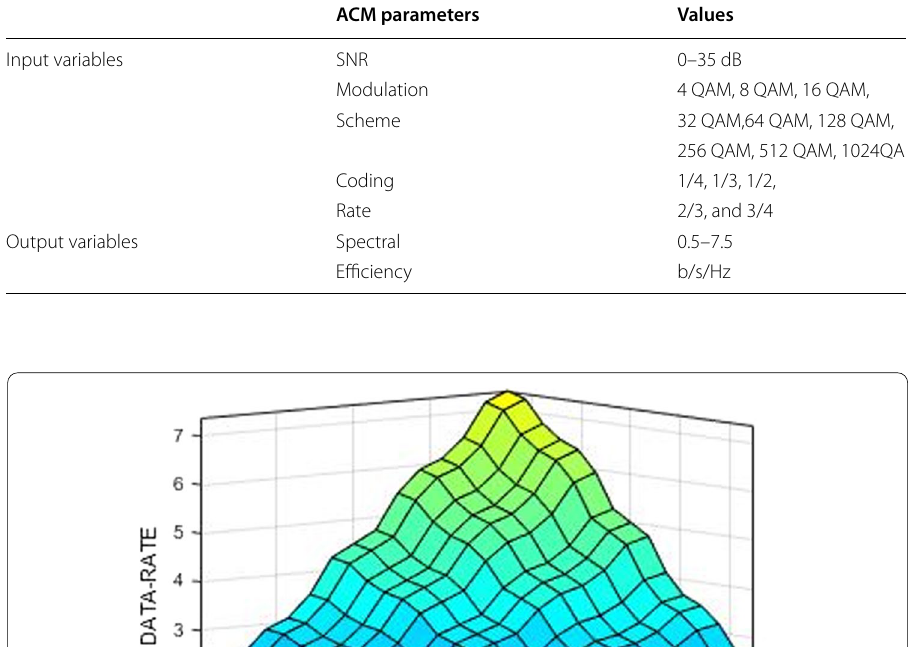
Table 9 Neuro-fuzzy parameters and their corresponding